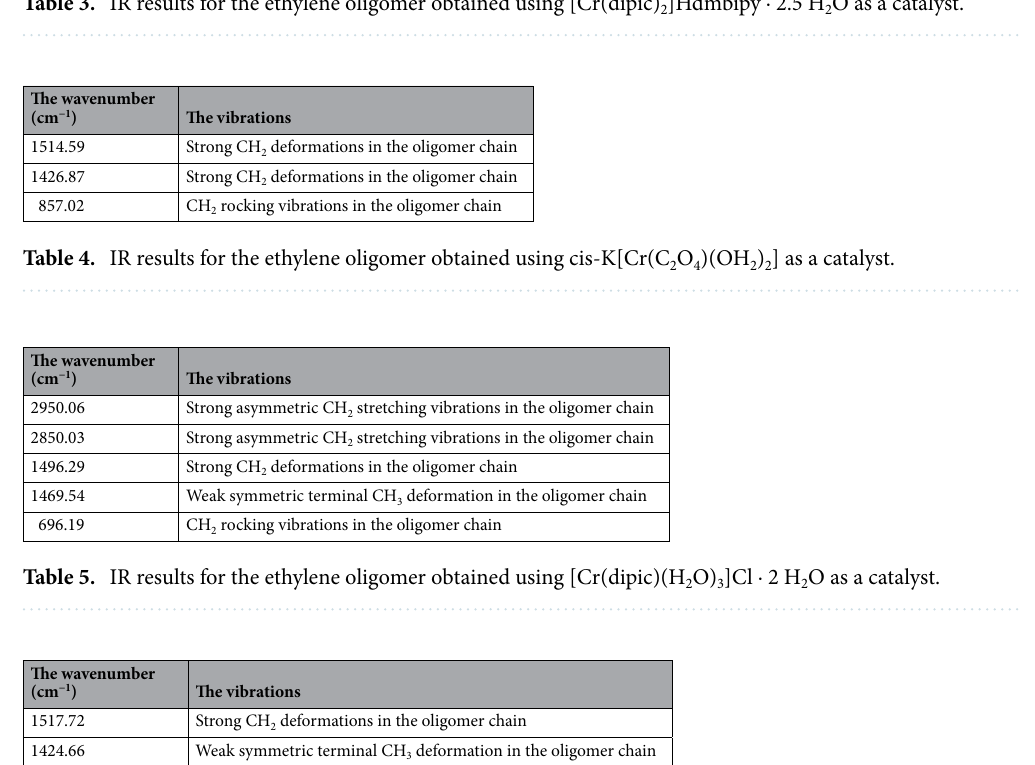
Table 3. IR results for the ethylene oligomer obtained using [Cr(dipic) 2 ]Hdmbipy ∙ 2.5 H 2 O as a catalyst.